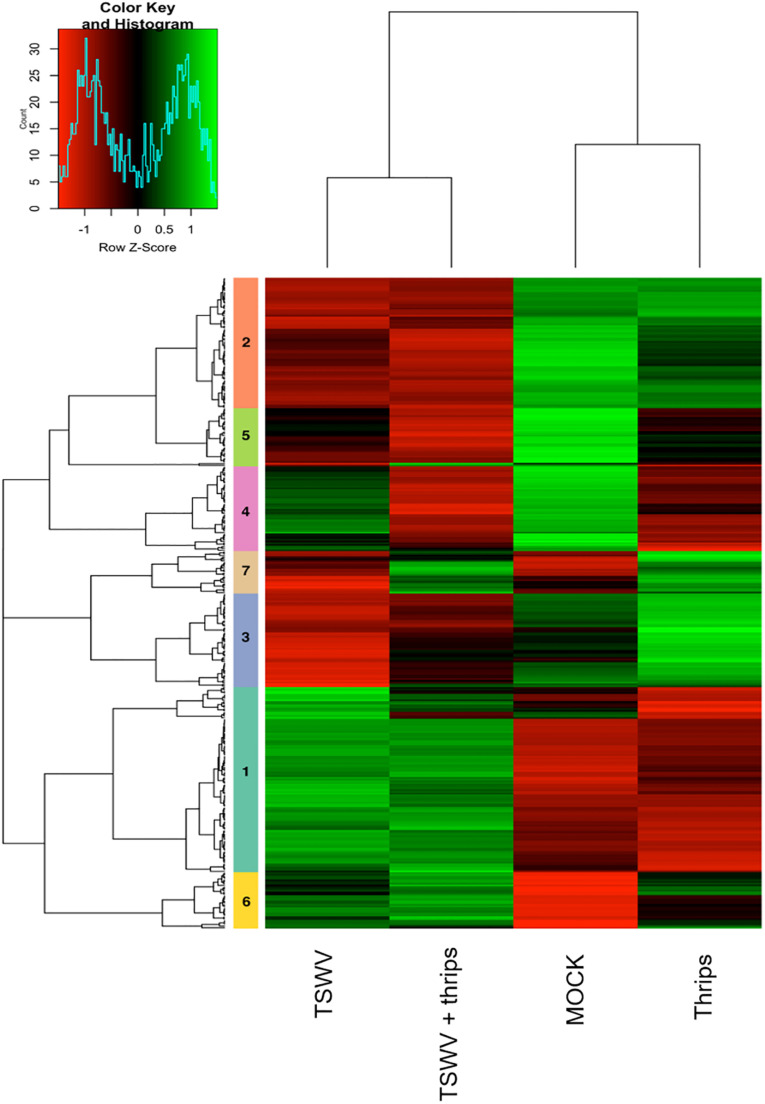
Hierarchical clustering of differentially-expressed genes in candidate pathways including defense and phytohormones, photosynthesis, cell wall organization, and protein metabolism. Heatmap showing the correlations of genes and treatments based on the averaged normalized hybridization data from 3 replicates per treatment. The row clusters (numbered 1 to 7) indicate genes that are correlated in terms of their expression and treatment from green (positive correlation) to red (negative correlation). The list of genes in each cluster is provided in Supplementary Table 6.